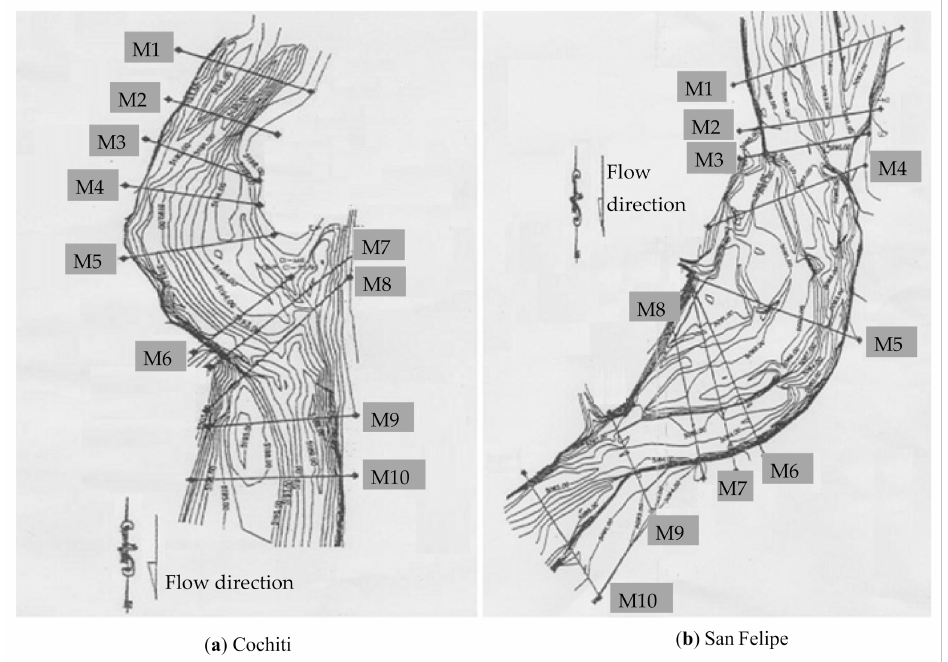
Figure 3. Prototype reach topographies (Cochiti topography, downstream; San Felipe topography,